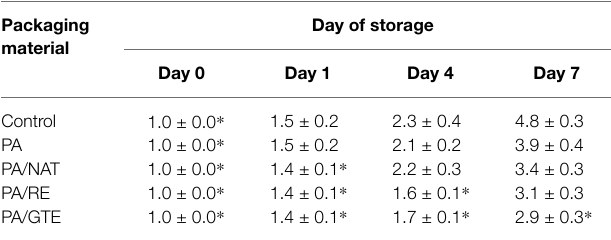
TABLE 5 | Sensory evaluation of chicken breast fillets samples packed in aluminum foil (control), PA, PA/NAT, PA/RE, and PA/GTE determined as final score of acceptability during 7 days storage at 7 ° C (values 1.0 ± 0.0 indicate the optimal quality). Packaging